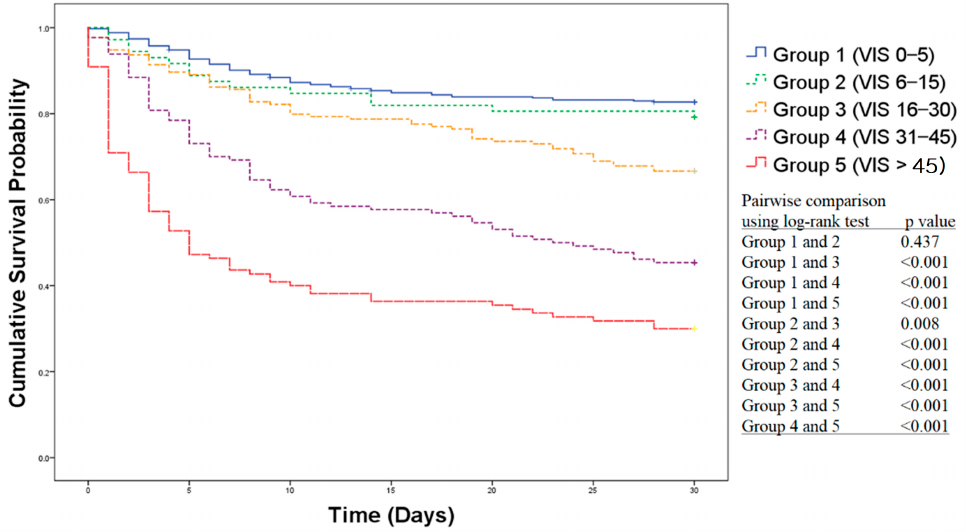
Figure 2. Kaplan–Meier survival curve of each VIS group. VIS: vasoactive–inotropic score. We performed ROC curves analysis with VISmax, the APACHE II score, the SOFA score, the cardiovascular component of SOFA score, and initial lactate levels to predict 30-day mortality. We performed pairwise comparisons between the variables. The dis- crimination power of VISmax for 30-day mortality was comparable to that of the SOFA score (AUC = 0.724; 95% CI: 0.694–0.753 vs. AUC = 0.734; 95% CI: 0.704–0.736; p = 0.518). The discrimination power of VISmax for 30-day mortality was comparable to that of the APACHE II score (AUC = 0.721; 95% CI: 0.690–0.748; p = 0.632). VISmax had better discrim- ination power for 30-day mortality than the cardiovascular component of the SOFA score (AUC = 0.659; 95% CI: 0.628–0.690; p < 0.001) and initial lactate levels (AUC = 0.655; 95% CI: 0.623–0.686; p = 0.001). The optimal cut-off value of VISmax to predict 30-day mortality was 31 (sensitivity: 52.7%, specificity: 83.1%). In addition, we presented 30-day mortality for the six different groups generated by the two VISmax categories and the three lactate groups in Table 5. Table 5. Thirty-day mortality for the six different groups generated by the two VISmax categories and the three lactate groups.